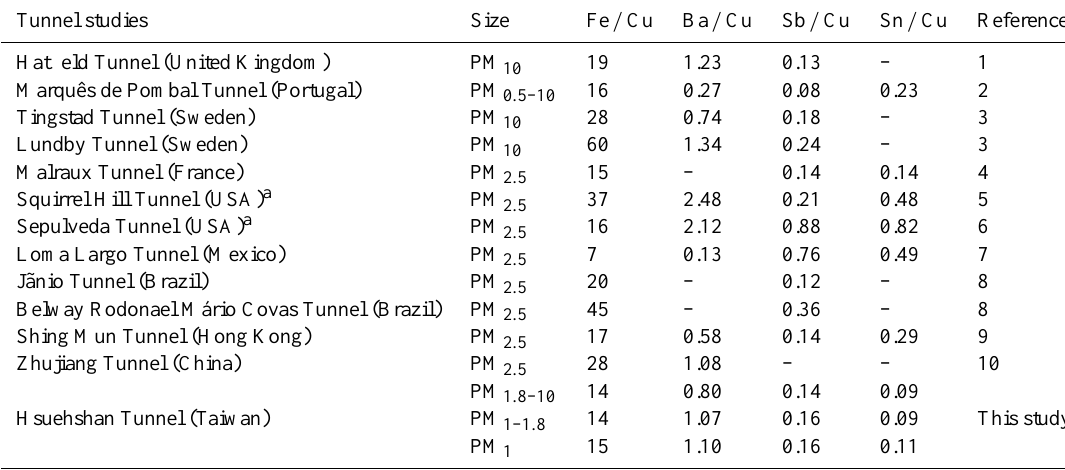
Table 4. Ratios of specific elements to Cu in tunnel PM. Tunnel